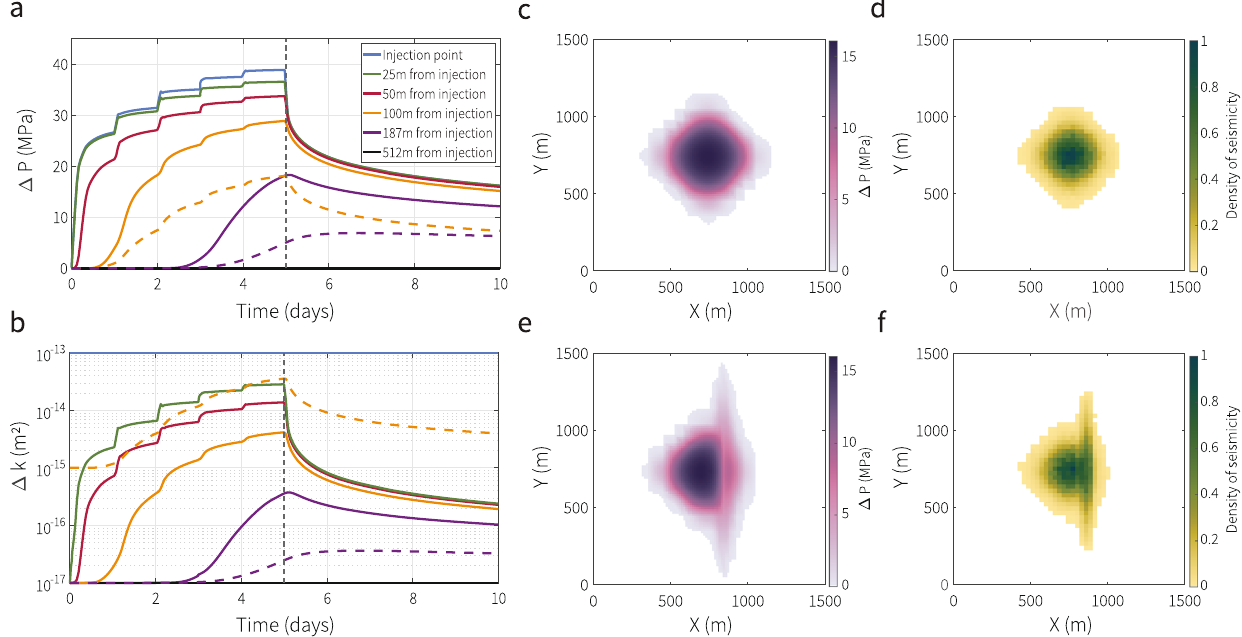
Fig. 2 Modelling results for the step increasing injection. Changes in pressure ( a ) and permeability ( b ) during the injection cycle, dashed lines correspond to the case with a fault. Distribution of the pressure changes after 10 days for the cases without a fault ( c ) and with a fault ( e ). Density of the seismicity averaged over all realisations without a fault ( d ) and with a fault ( f